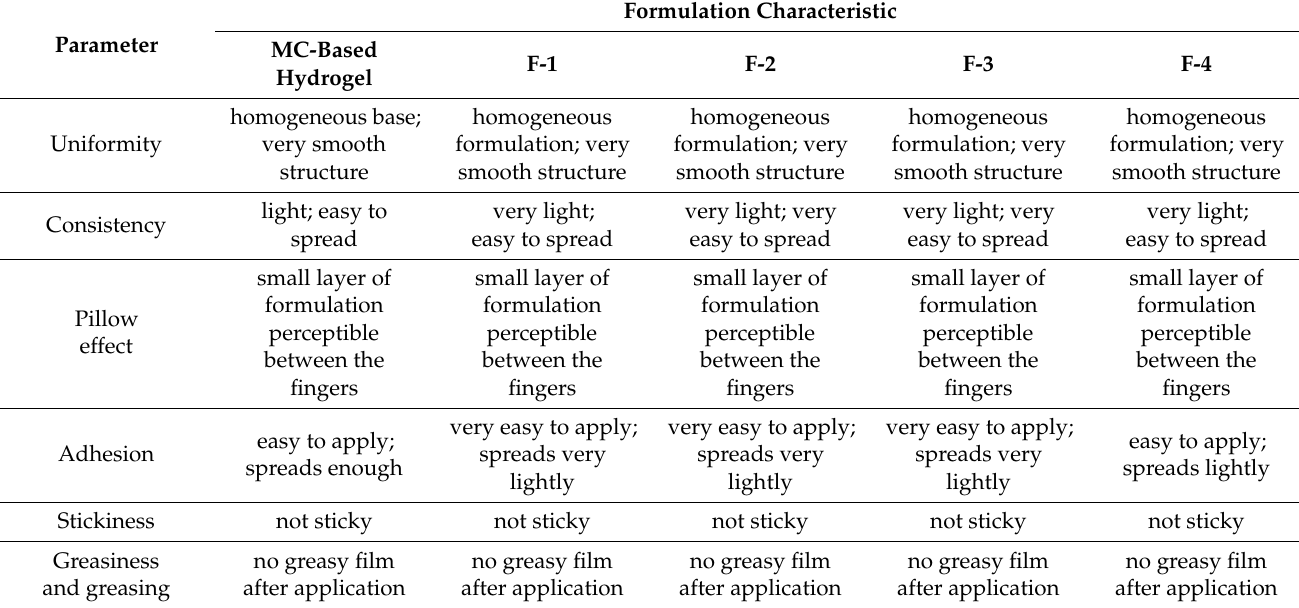
Table 6. Sensory evaluation of formulated hydrogels